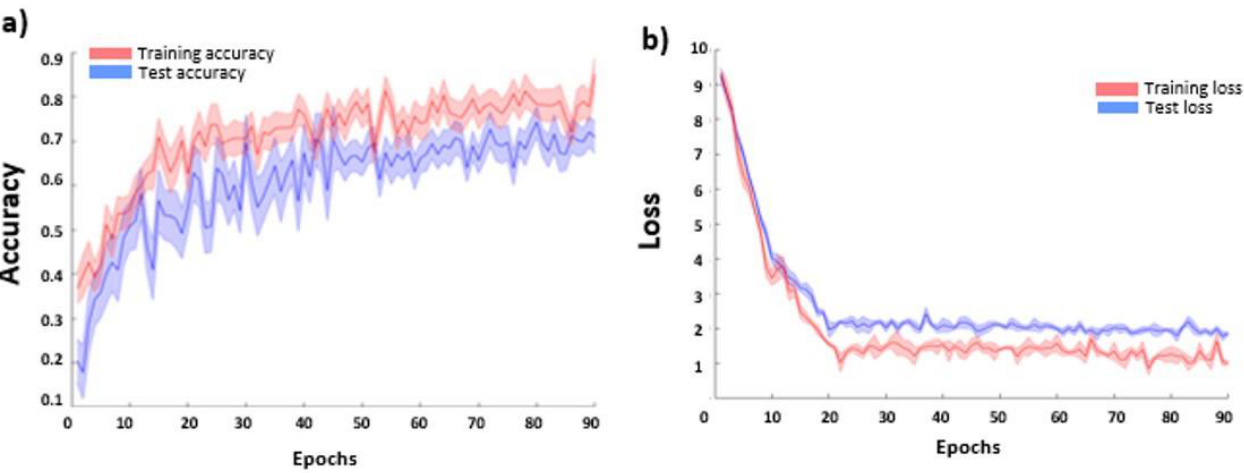
Figure 8. CNN average (and related standard errors) cross-validated ( a ) accuracy and ( b ) loss function values as a function of the training epoch for the training and test sets.